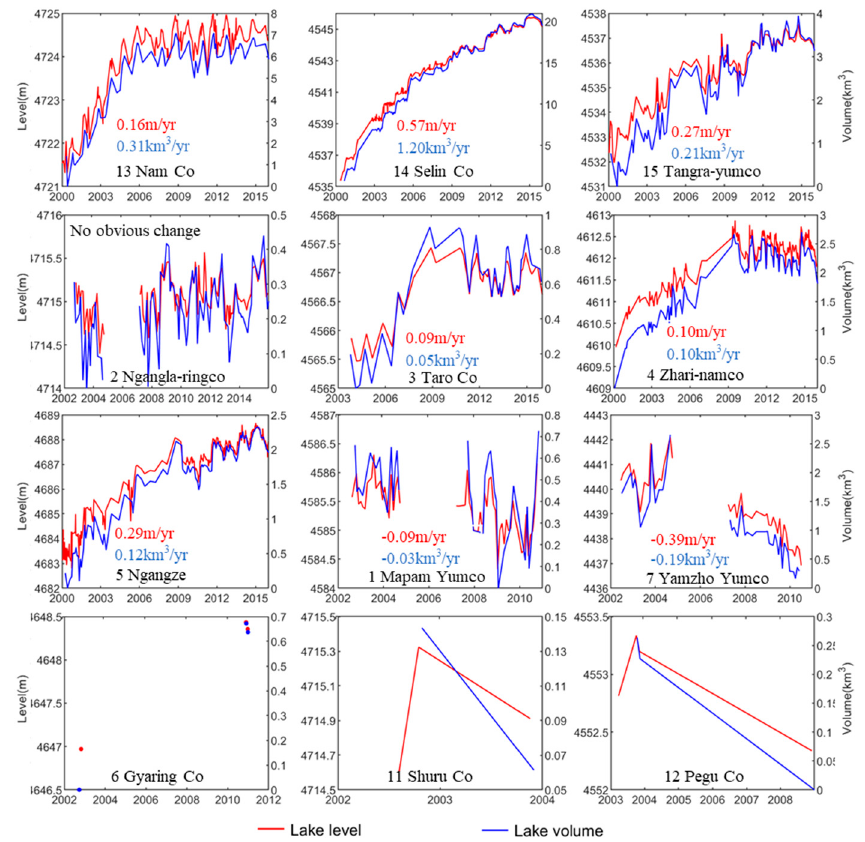
Figure 5. Lake level series (red lines) and volume changes (blue lines) of the studied lakes in 2000–2015. The number before the lake name is the lake ID.